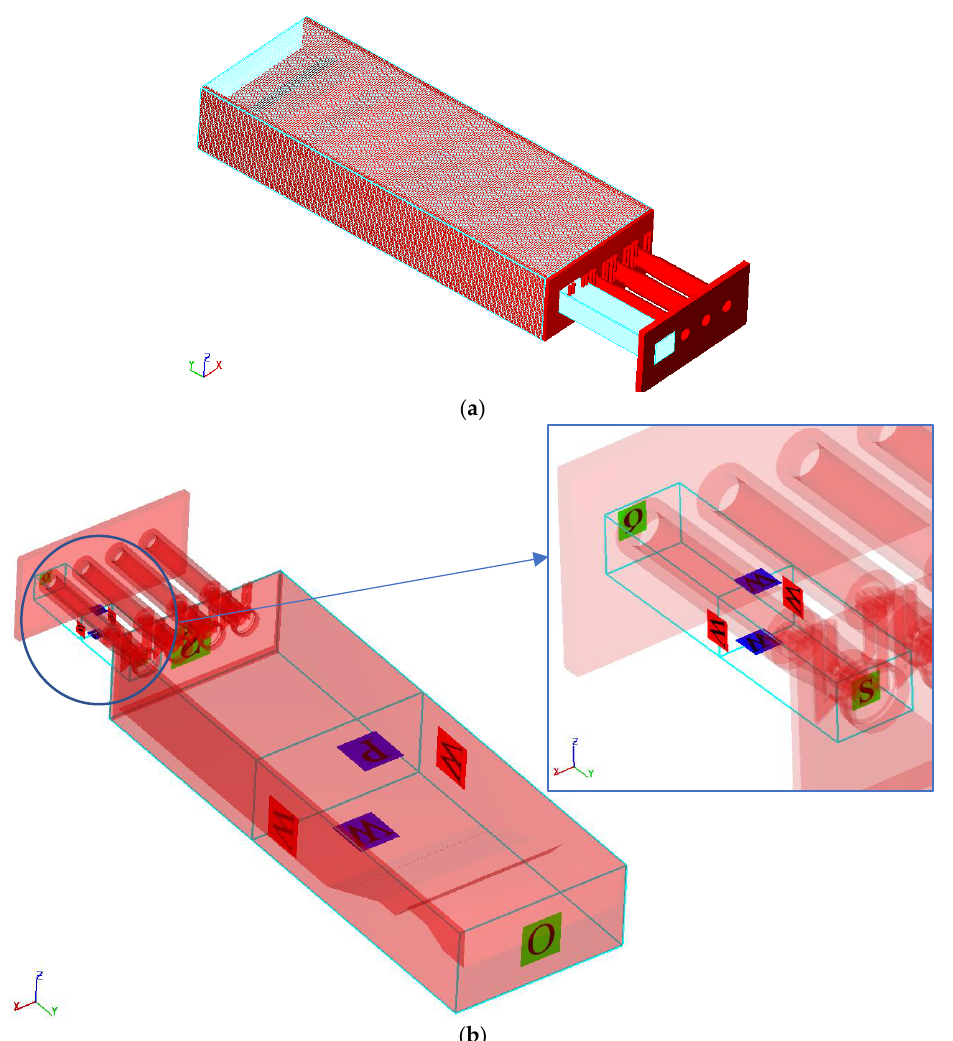
Figure 4. ( a ) Flow3D-generated orthogonal mesh associated with STL; and ( b ) domain and boundary conditions in the Flow3D numerical model;.